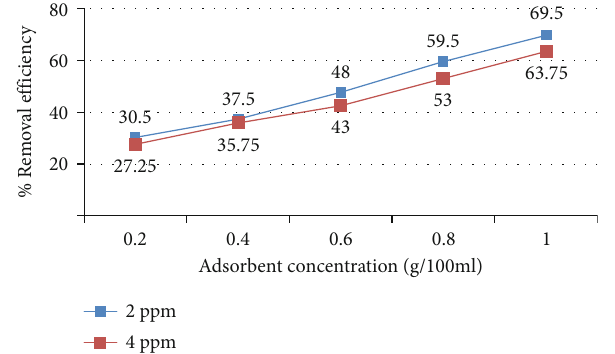
Figure 5: Coconut shell charcoal adsorbent initial fl uoride concentration 2 PPM and 4 PPM.